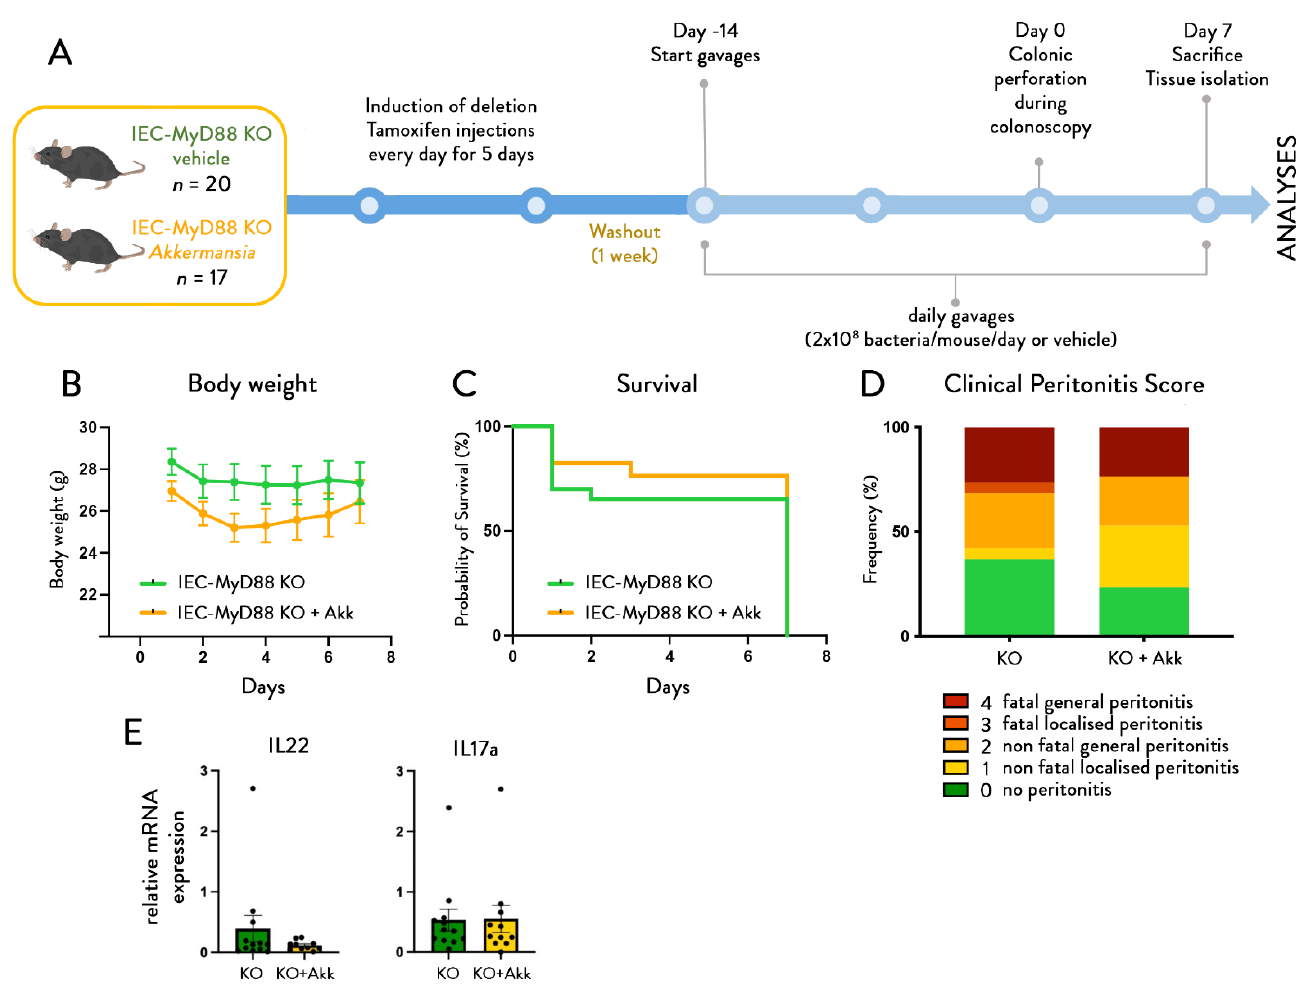
Figure 6. Mice with intestinal epithelial cell-specific deletion of Myd88 are not responding to the beneficial effects of A. muciniphila on mortality and peritonitis . ( A ) Experimental design. ( B ) Body weight evolution, ( C ) survival rates, and ( D ) peritonitis scores after colonic perforation. ( E ) IL22 and IL17 in the colon of mice with an intestinal-epithelial-cell-specific deletion of Myd88 (IEC-MYD88 KO) with or without treatment with A. muciniphila ( n = 20 per group). Data are shown as mean ± SEM, black dots (dotplots) represent individual values for each animal. Probability of survival assessed using Gehan–Breslow–Wilcoxon test and Chi-square test for clinical peritonitis score, p -value > 0.05. Non-parametric Mann–Whitney test used to assess IL22 and IL17, p -value >